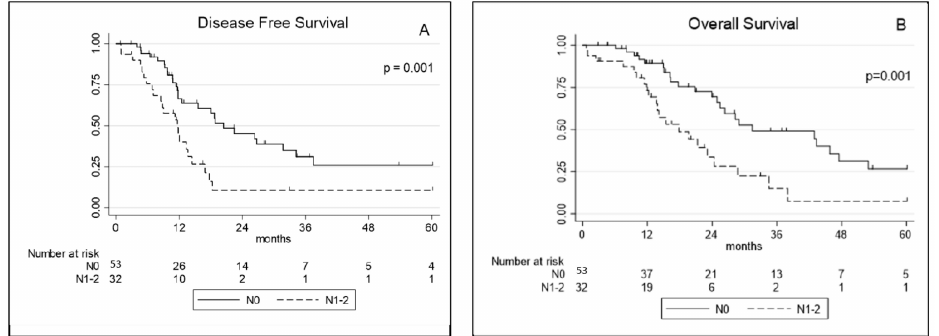
Figure 2. ( A ) Disease-free survival and ( B ) overall survival curves for extended pleurectomy decortication (eP/D) according to pathological node involvement (pN0 vs. pN+). N0: no nodes involvement, N1–2: nodes involvement